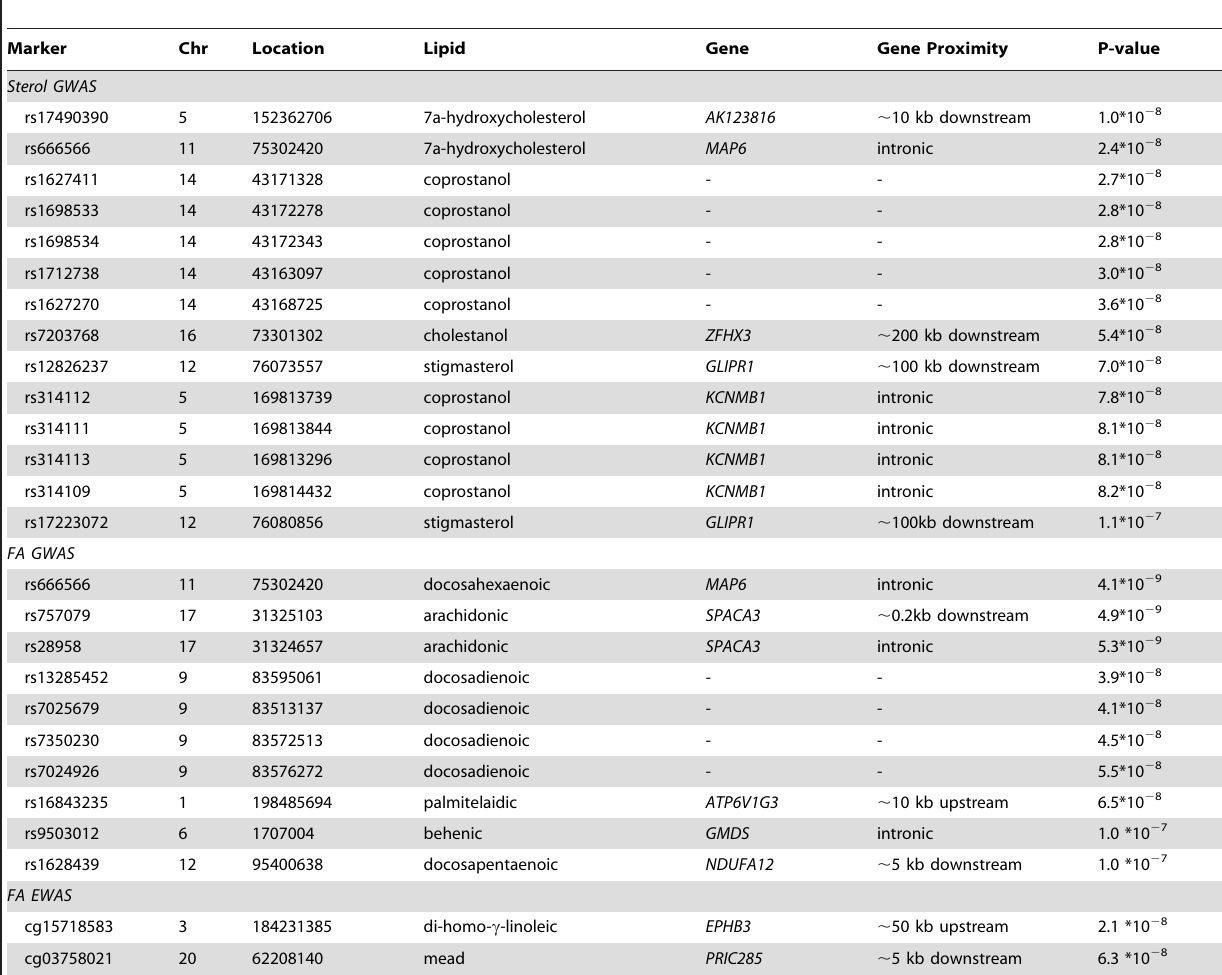
Table 3. Top genome-wide association study (GWAS) and epigenome-wide association study (EWAS) results for postprandial sterols and fatty